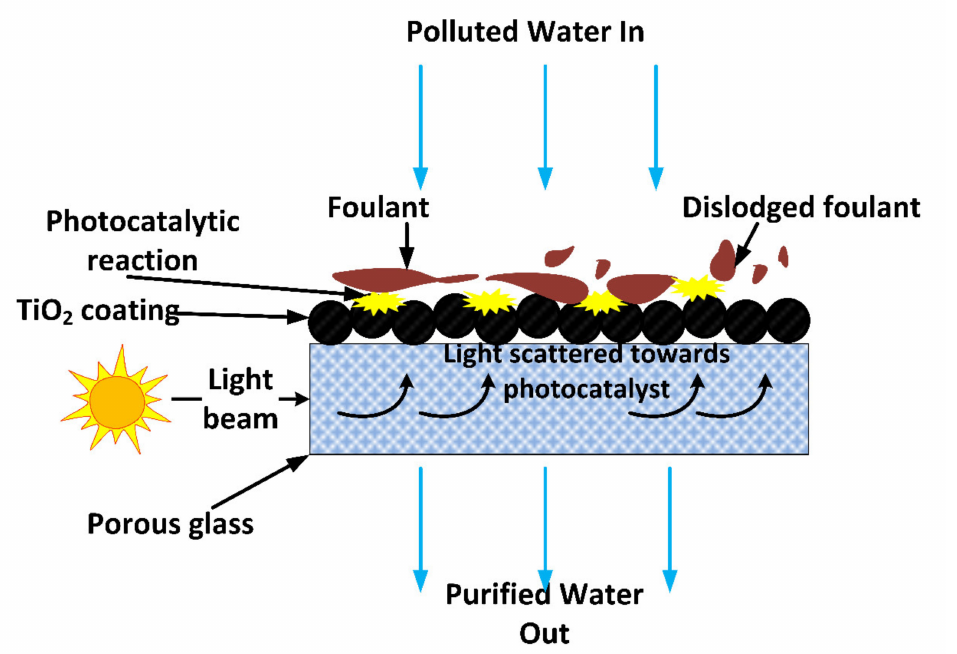
Figure 15. Membrane fouling reduction induced by the addition of TiO 2 coating through photodegra- dation. Reprinted from